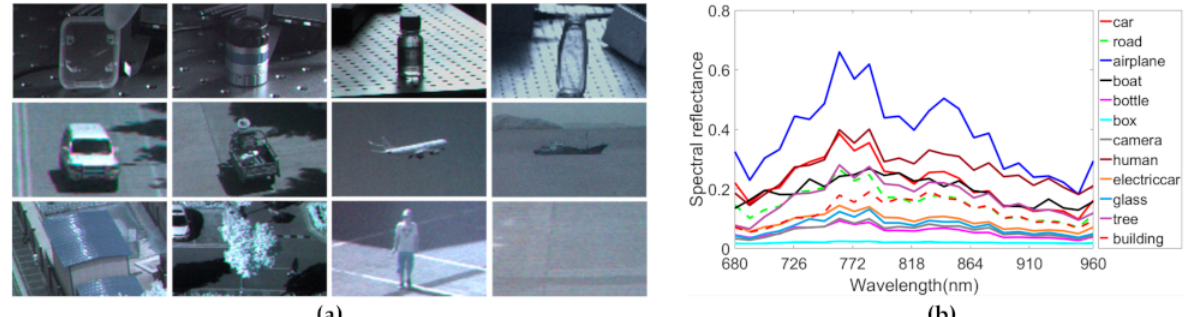
Figure 2. Spectral signatures of various materials measured at a center pixel of each object. ( a ) Target objects and various background materials. From left to right and top to bottom: box, camera, bottle, glass, car, electric car, airplane, boat, building, tree, human, and road. ( b ) Reflectance of various targets over 680-960 nm in